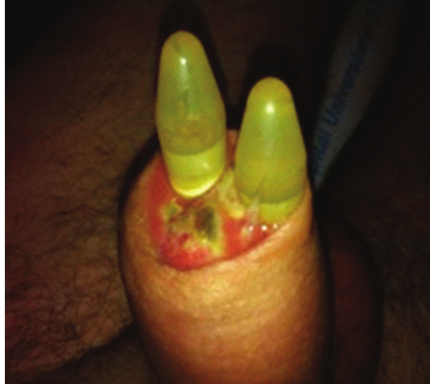
Figure 4: Extrusion of the penile prosthesis through the glans.